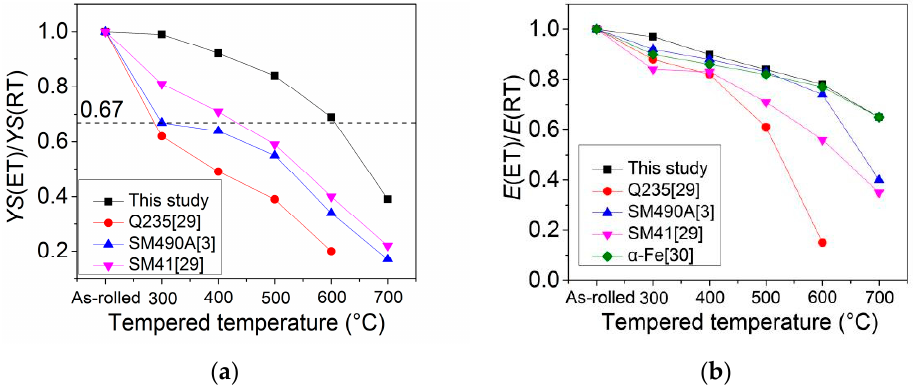
Figure 12. YS (ET)/ YS (RT) and E (ET)/ E (RT) at different temperatures. Figure 12. ( a ) YS (ET)/ YS (RT) and ( b ) E (ET)/ E (RT) at different